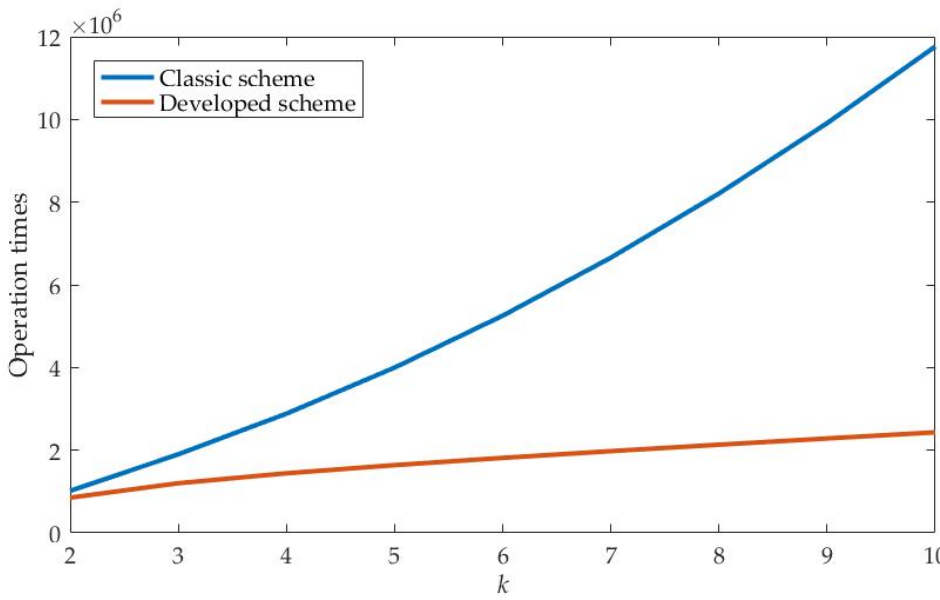
Figure 3. Comparison of the number of operations performed by the two schemes on the change of k .